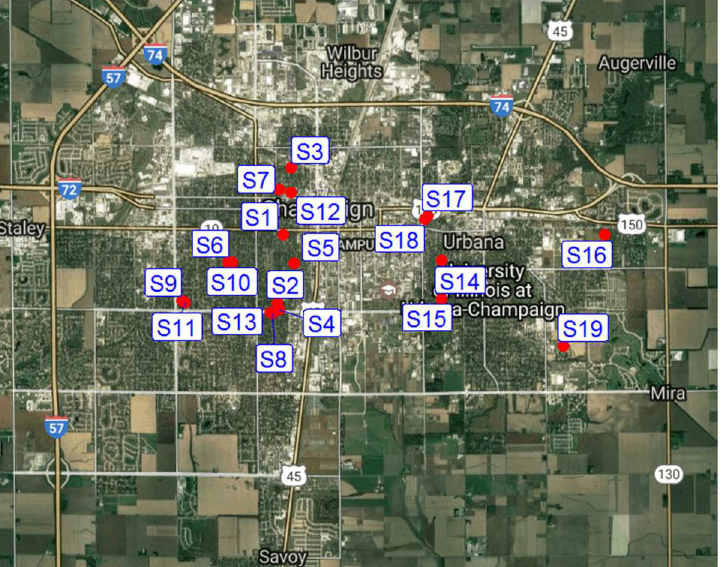
Fig 1. Map of the study area showing the location of the traps. S = trap site, S1 = 504 S Lynn St, ChampaignIL; S2 = 1509 Grandview Dr, ChampaignIL; S3 = 408 W Maple St, ChampaignIL; S4 = 1809 GrandviewDr, Champaign IL; S5 = 805 S. Prairie St, Champaign IL; S6 = 1116Charles St, ChampaignIL; S7 = 604 W Hill St, ChampaignIL; S8 = 1605 Coronado Dr, ChampaignIL; S9 = 1413 S Western Ave, ChampaignIL; S10 = 909 S McKinley,ChampaignIL; S11 = 1418 S Western Ave, ChampaignIL; S12 = 409 W Hill St, ChampaignIL; S13 = 705 W Kirby Ave, ChampaignIL; S14 = 602 NevadaSt, Urbana IL; S15 = 602 Vermont Ave, UrbanaIL; S16 = 2402 E Elm St, UrbanaIL; S17 = 804 W Main St, Urbana IL; S18 = 807 W Main St, Urbana IL; S 19 = 2010 Morrow Ct, UrbanaIL.